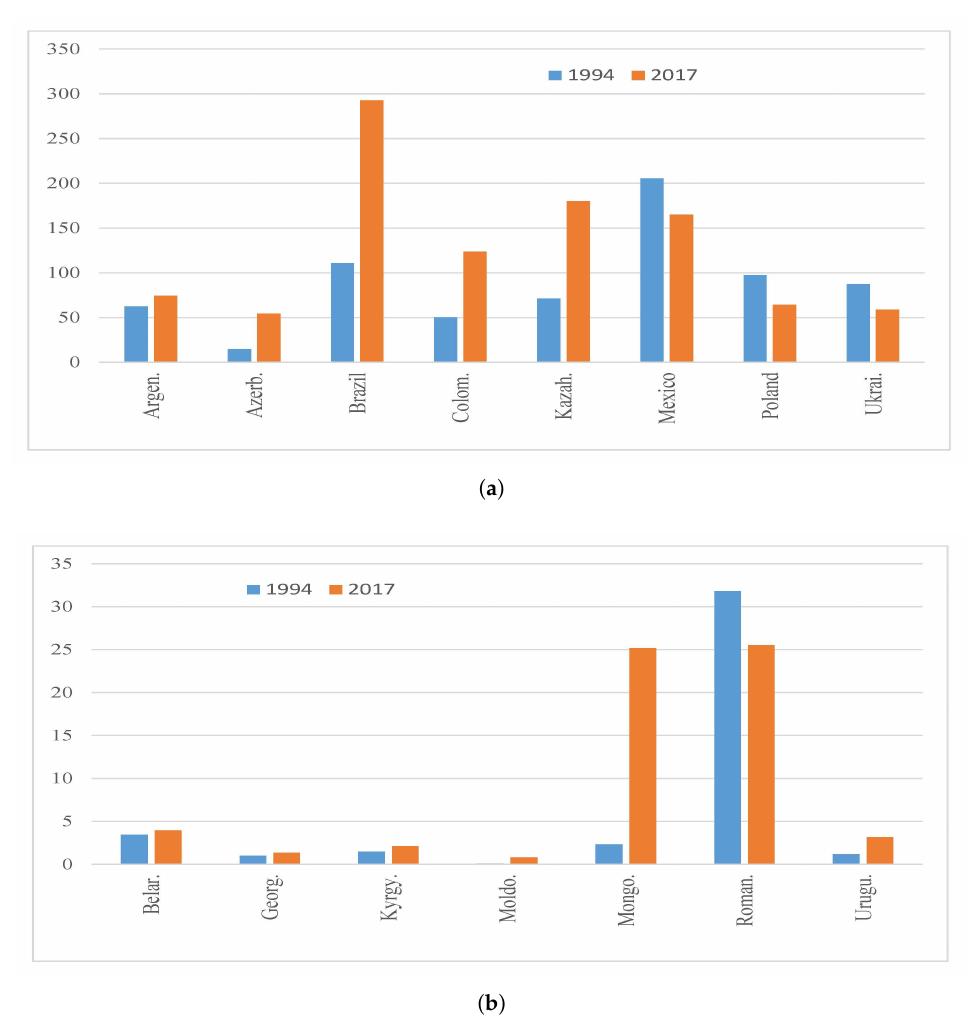
Figure 2. Energy Production, 1994 and 2017. Data obtained from the International Energy Agency. ( a ) displays countries with higher energy production, while those with lower energy production are in part ( b ). Table 1. Country Level Summary Statistic for Select Variables,